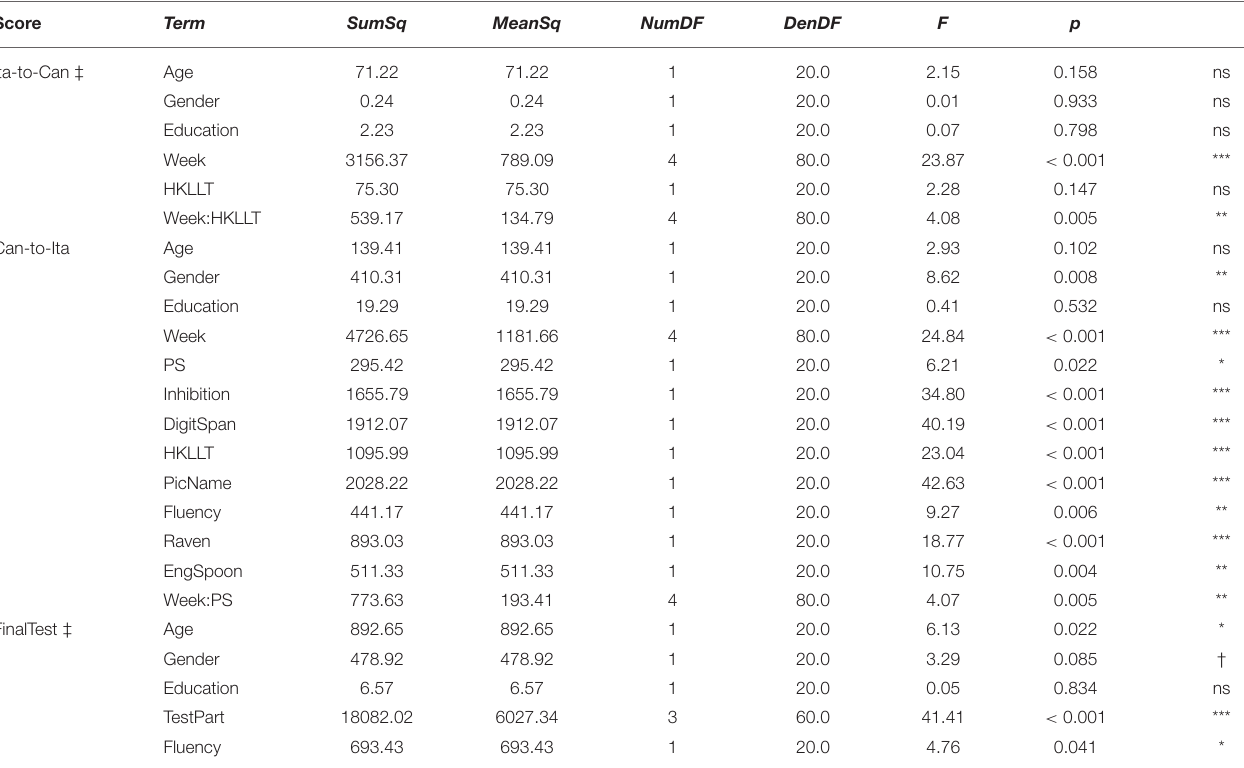
TABLE 6 | Cognitive models for the in-class Ita-to-Can and Can-to-Ita scores and for the final test, obtained after backward elimination of the full models. Score